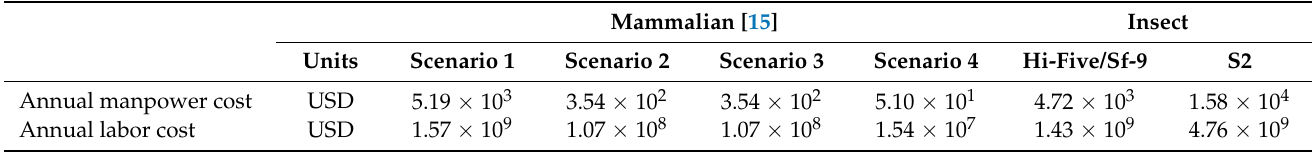
Table 6. Outcome values relating to labor produced by the model for four mammalian scenarios proposed in the Risner et al. paper compared to outcomes for Hi-Five/Sf-9 and S2 insect cells